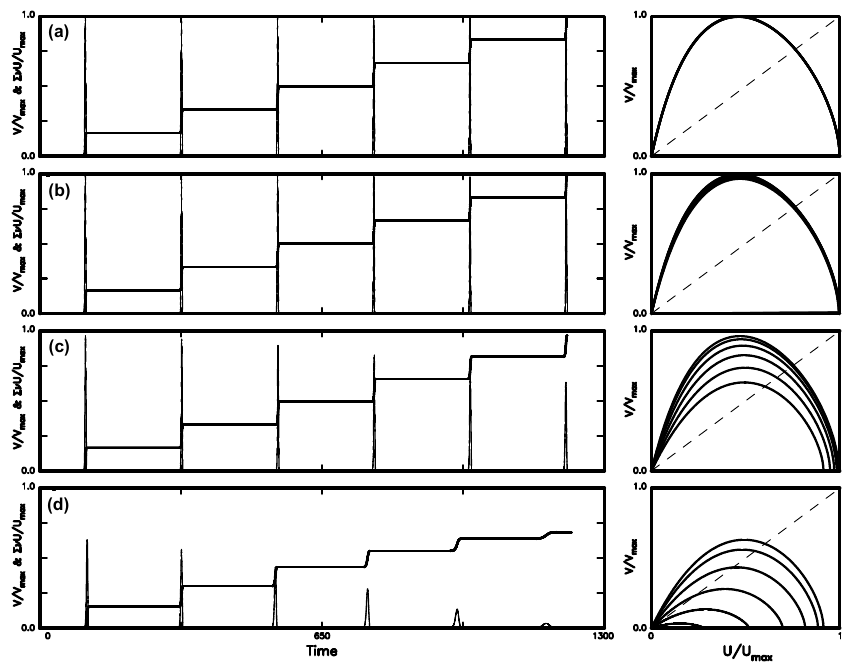
Figure 11. The time variations in V/V max (thin solid line) and cumulative slip (cid:54)U/U max (solid line) and the phase portrait of V/V max versus U/U max (solid line) for four values of C : (a) for C = 0.0001; (b) for C = 0.0010; (c) for C = 0.0100; and (d) for C = 0.0380 when U co = 0.1 and η =